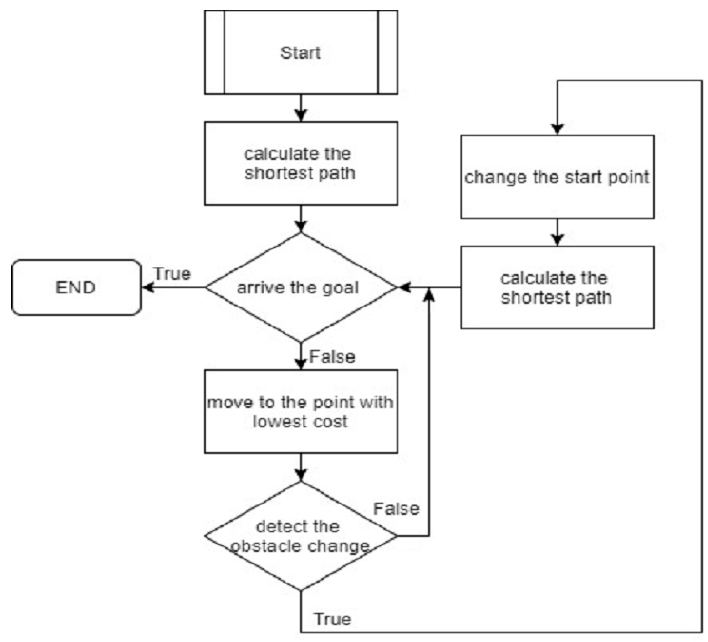
Figure 8. D* Lite algorithm flow chart.